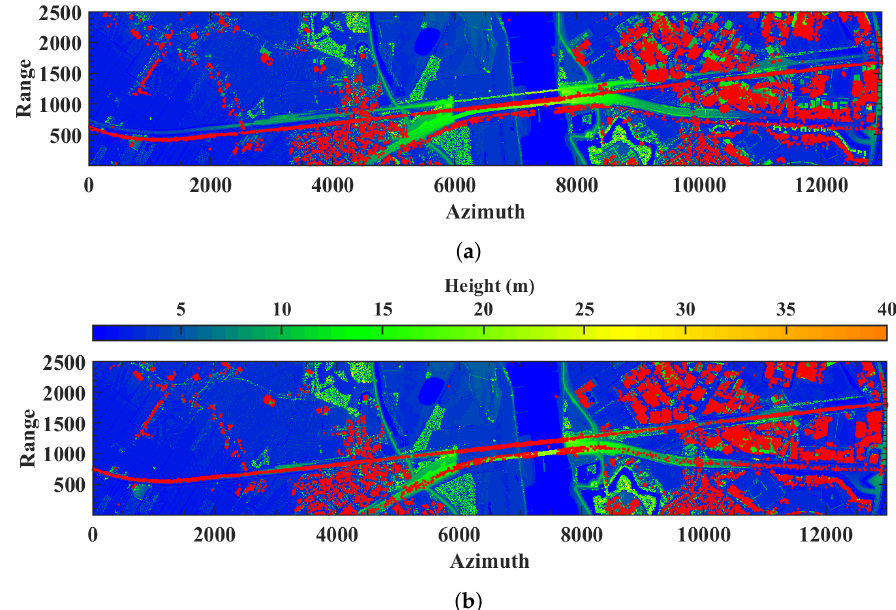
Figure 5. Distribution of the radar scatterers (red dots) relative to the LiDAR data (height-colored dots): ( a ) coordinates of radar scatterers before height offset correction; and ( b ) coordinates of radar scatterers after height offset